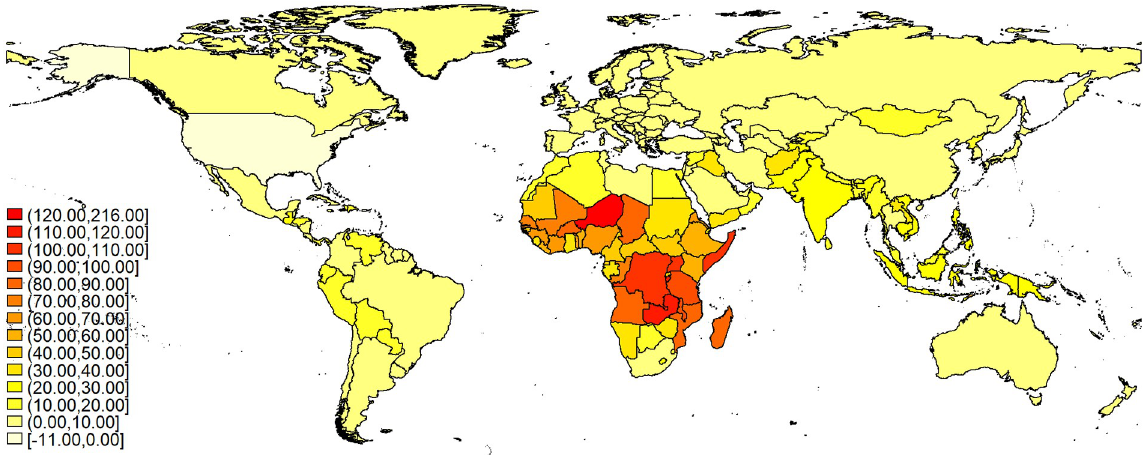
Fig 4. Estimated effect of BMI and height increase in Scenario 4 on energy requirements between 2010 and 2100.